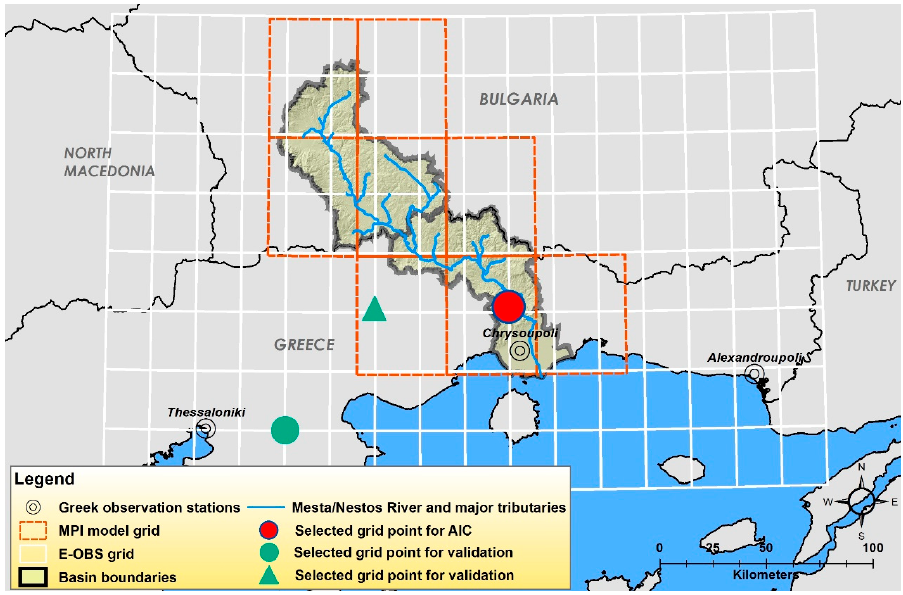
Figure 1. The studied area, which was the transboundary catchment of